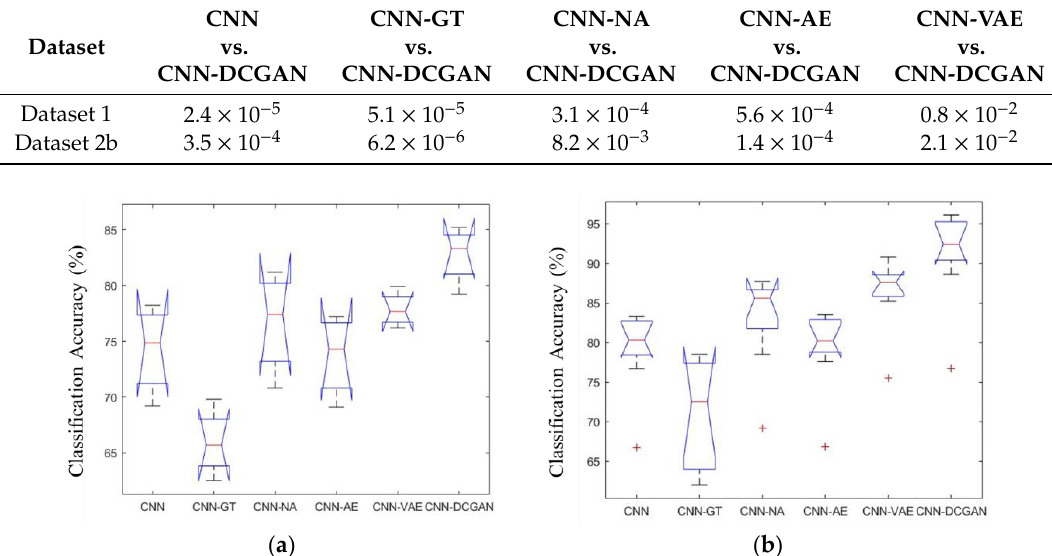
Figure 14. The ANOVA statistics of the classification accuracies of the methods for datasets 1 ( a ) and 2b ( b ). Sensors 2020 , 20 , x FOR PEER REVIEW Table 10. Paired t -test results ( p -values) between the CNN-DCGAN and other methods.